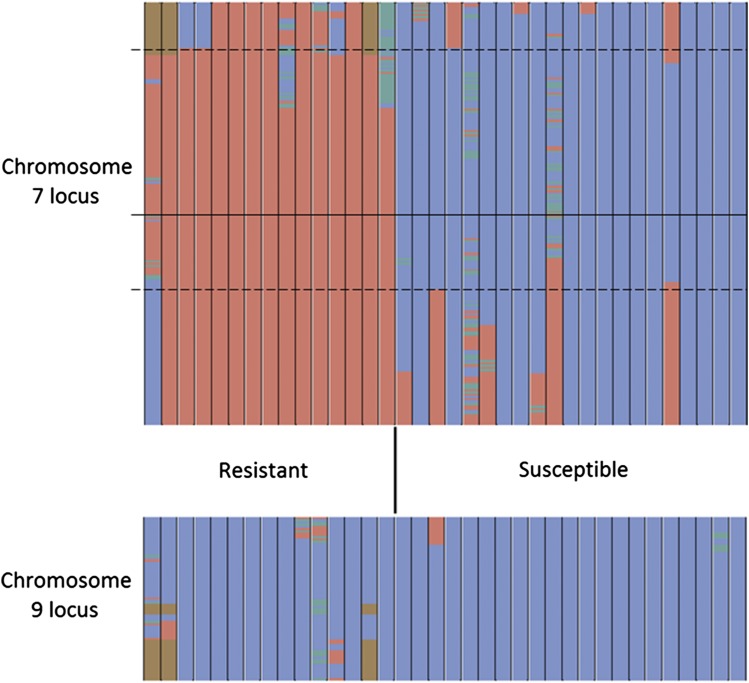
Genotypic markers within the two QTL for individual lines organized by phenotype. The vertical columns represent individual lines, and the color within the columns indicate the genotypic state of the markers: blue represents ‘Early Hegari-Sart’, red represents ‘Bk7’, green represents heterozygosity, and brown represents missing data. The scale on the y-axis is proportional to the number of markers. The reduced QTL region is indicated by the dashed black lines, while the solid black line indicates the position of the centromere on chromosome 7. Lines with ambiguous phenotypic data were excluded for clarity.